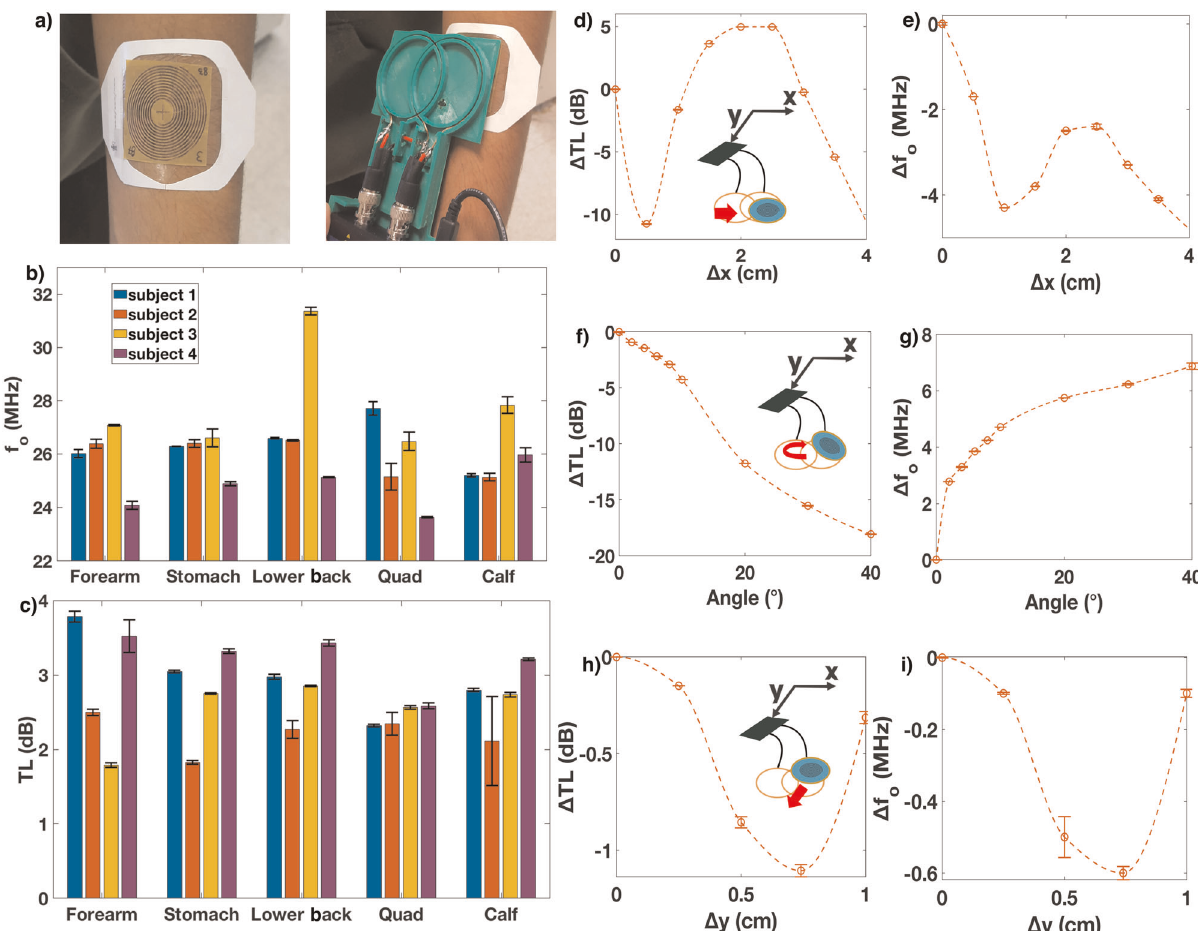
Fig. 5 Orientational dependence and sensor wearablility. a Resonant sensor sticker on forearm (left) and measurement with portable VNA with custom two-loop antenna head (right) (note: written informed consent was obtained from participants to use selected photos). Interhuman and intrahuman variation of f o ( b ) and Δ TL ( c ) for various regions of the body; population = 4, replicates = 5, error bars show s. d. x -direction translation effect on Δ TL ( d ) and f o ( g ). y -direction translation effect on Δ TL ( e ) and f o ( h ). Angle between reader antenna and resonator effect on Δ TL ( f ) and f o ( i ); error bars show s.